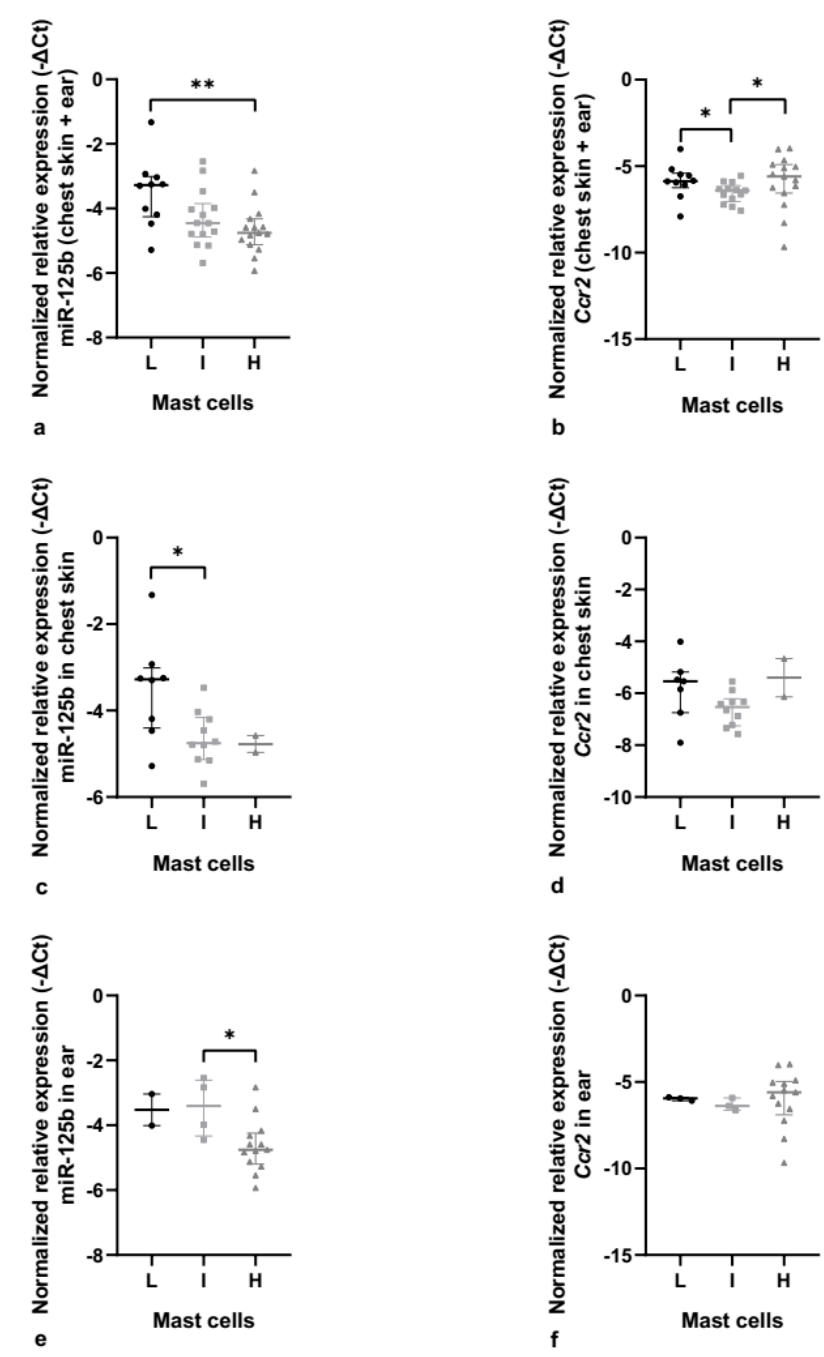
Figure 7. MiR-125b and Ccr2 relative expression in K14-HPV16 transgenic mice. ( a ) MiR-125b relative expression in chest skin and ear tissue, together. There are statistically significant differences between the low and high mast cell counts (** p < 0.01). ( b ) Ccr2 relative expression in chest skin and ear tissue, together. We observed statistically significant results between the low and intermediate mast cell counts (* p < 0.05) and between the intermediate and high mast cell counts (* p < 0.05). ( c ) Normalized relative expression of miR-125b in chest kin. Statistically significant differences were observed between the low and intermediate mast cell counts (* p < 0.05). ( d ) Normalized relative expression of Ccr2 in chest skin. ( e ) MiR-125b relative expression in ear tissue. Statistically significant differences were found between the intermediate and high mast cell counts (* p < 0.05). ( f ) Ccr2 relative expression in ear tissue. L: low mast cell count; I: intermediate mast cell count; H: high mast cell